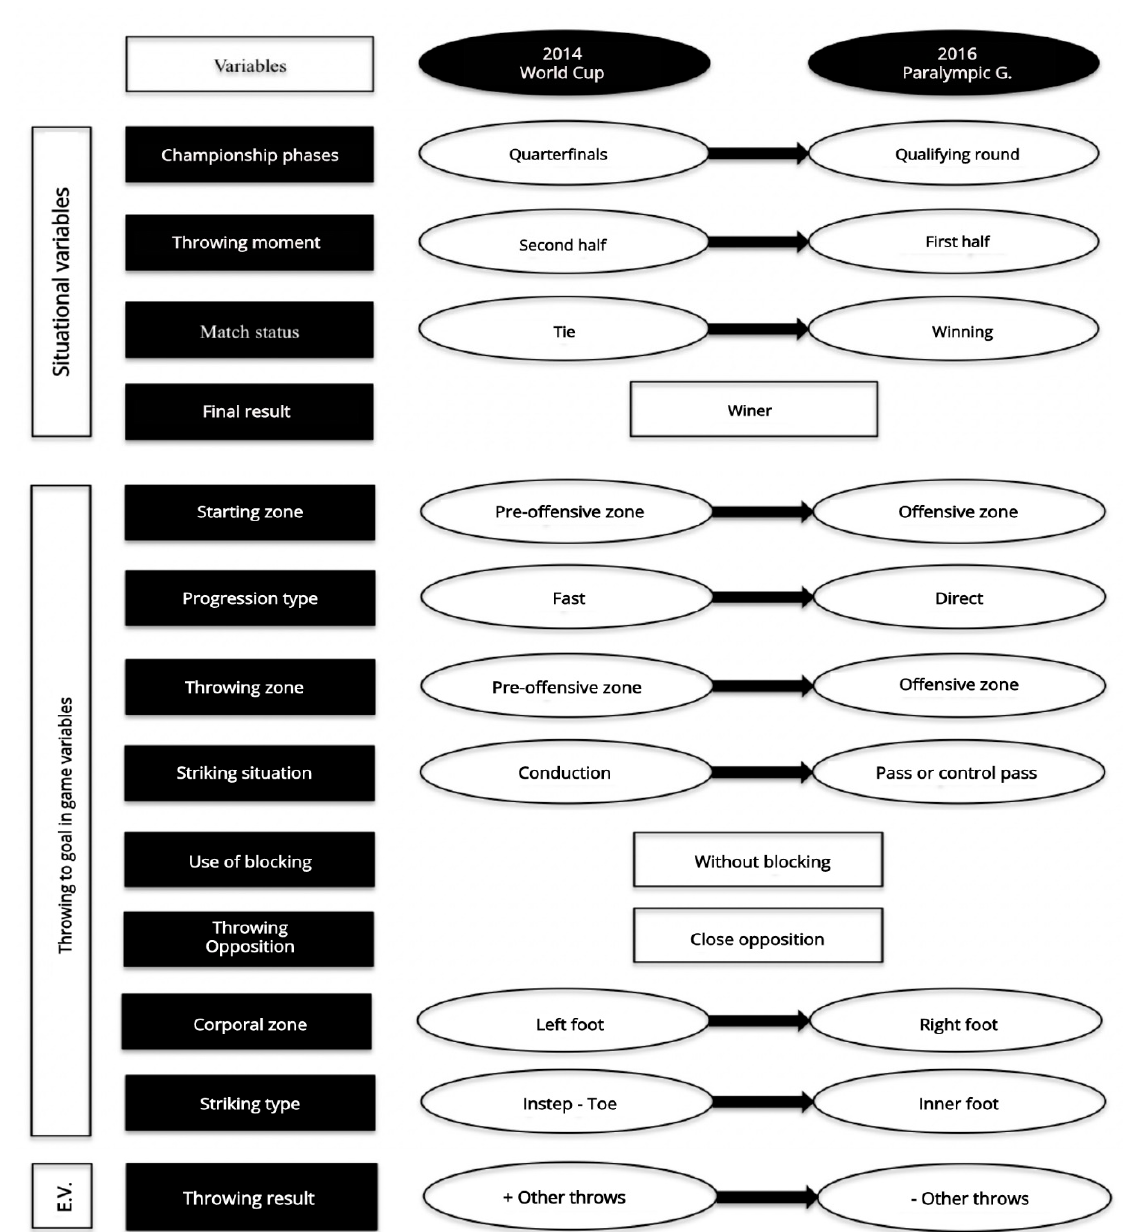
Figure 3. Game evolution between the World Cup and the Paralympic Games in Fa5. E.V: Efficiency variable.